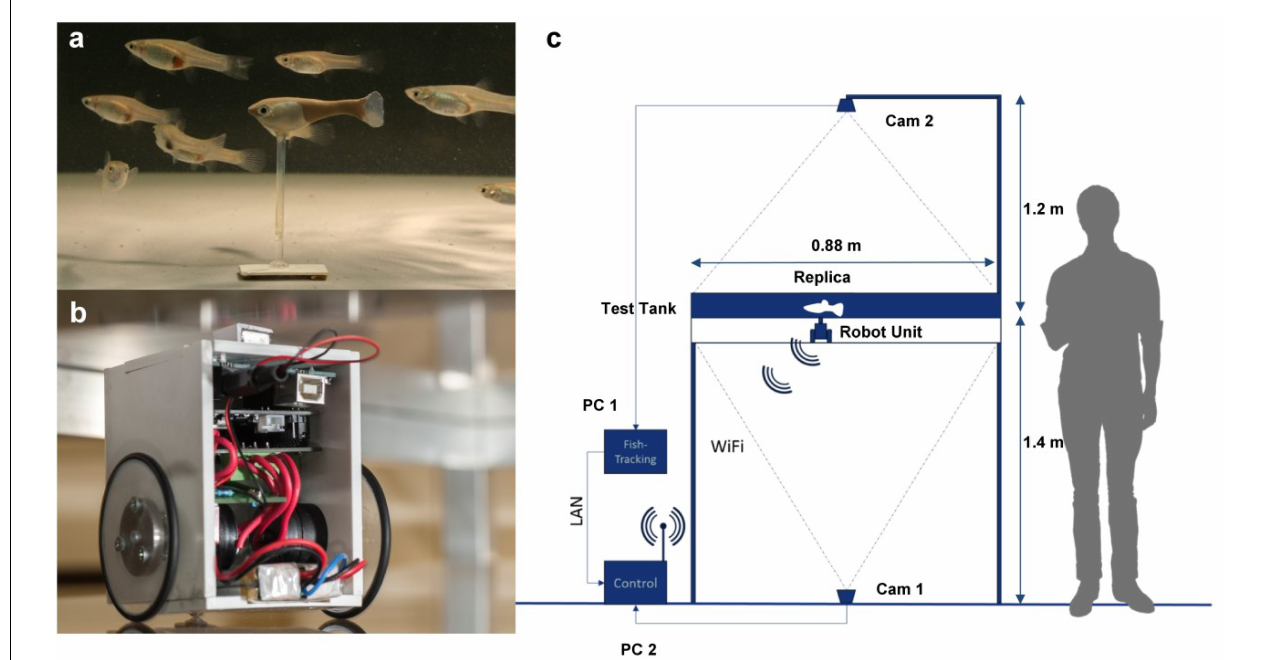
FIGURE 1 | The Robofish system. (a) Guppy-like replica (3D printed and colored) with a group of female guppies in the test arena. (b) Close-up of the robot unit. The robot unit is driving on a second level below the test arena (c) .